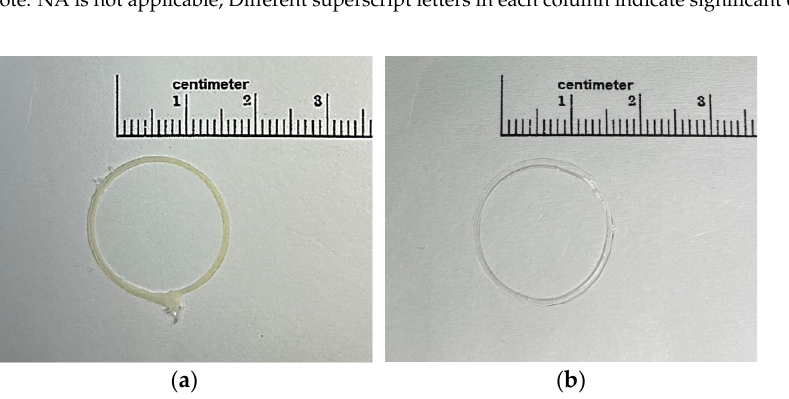
Figure 3. Printed filament diameter of 3D ‐ MTZ ( a ) and blank ( b ). (cid:1)